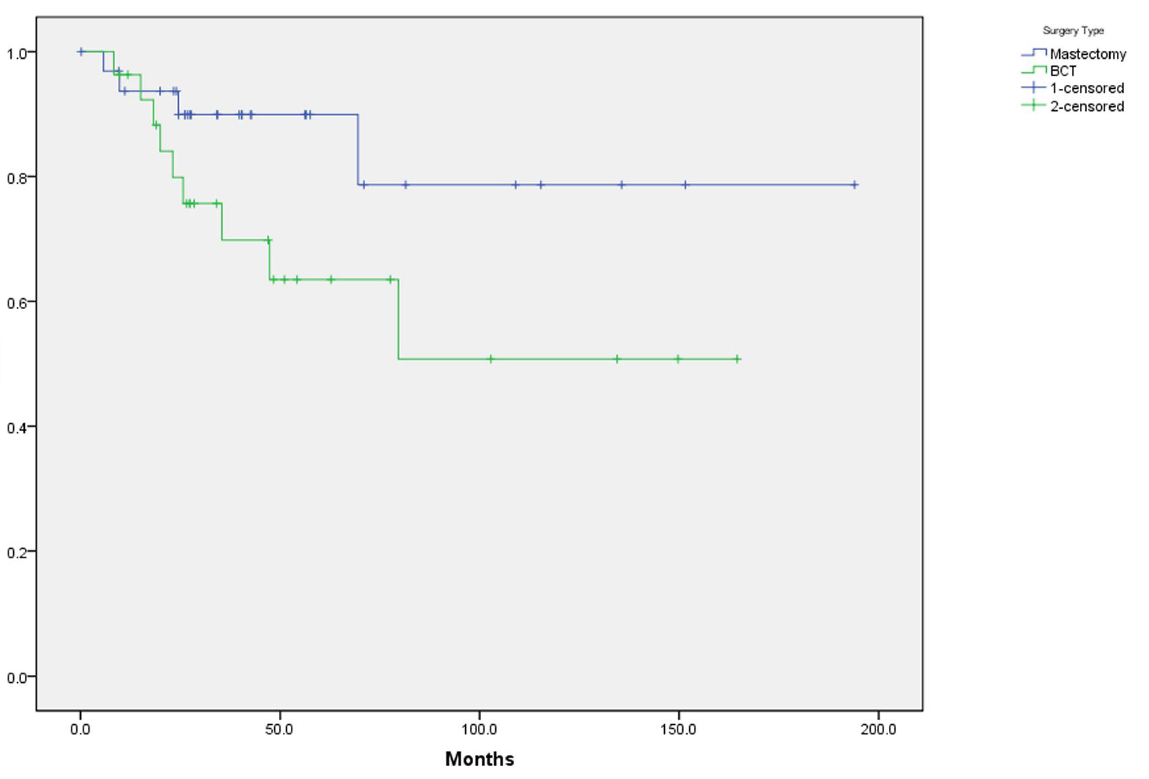
Figure 1. K-M Curve Showing Loco-regional Recurrence Free